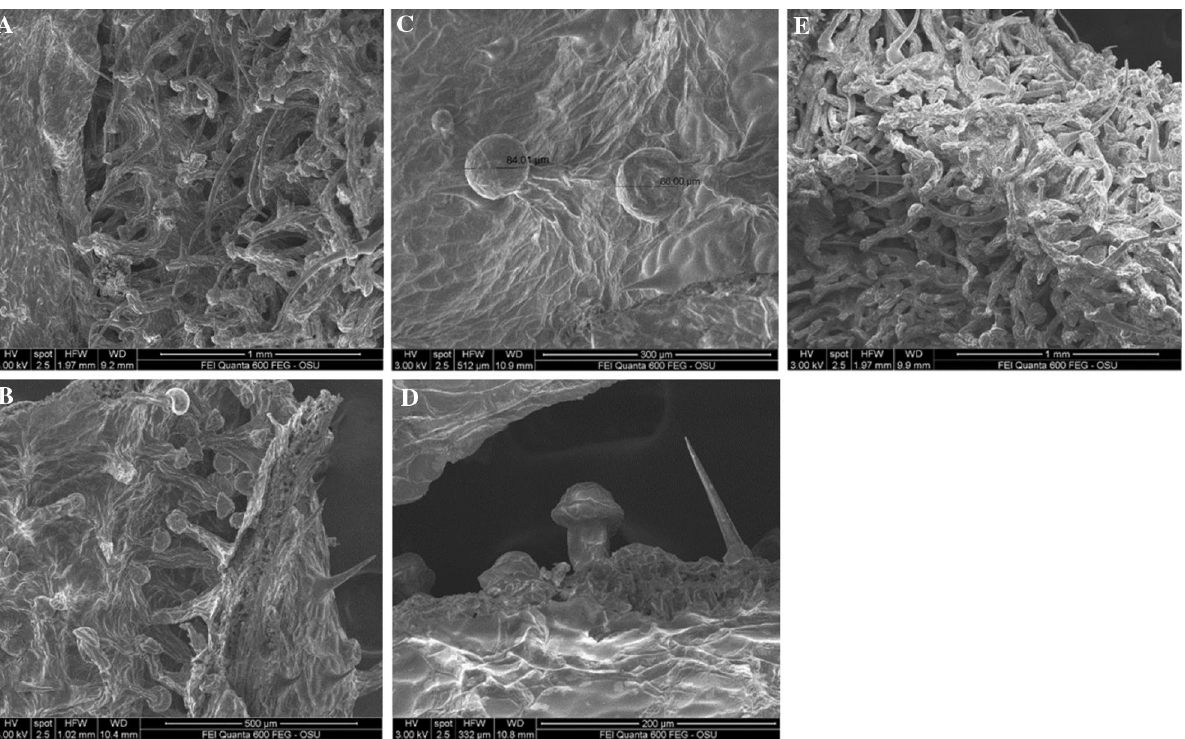
Figure 3. ( A ) Red Bordeaux extracted flower/leaf parts. ( B ) Red Bordeaux extracted flower/leaf parts. ( C ) Red Bordeaux extracted leaf with non-destructed glandular trichomes. ( D ) Red Bordeaux extracted leaf with non- destructed glandular trichomes and well preserved cystolithic trichomes. ( E ) Cherry Wine extracted flower/leaf